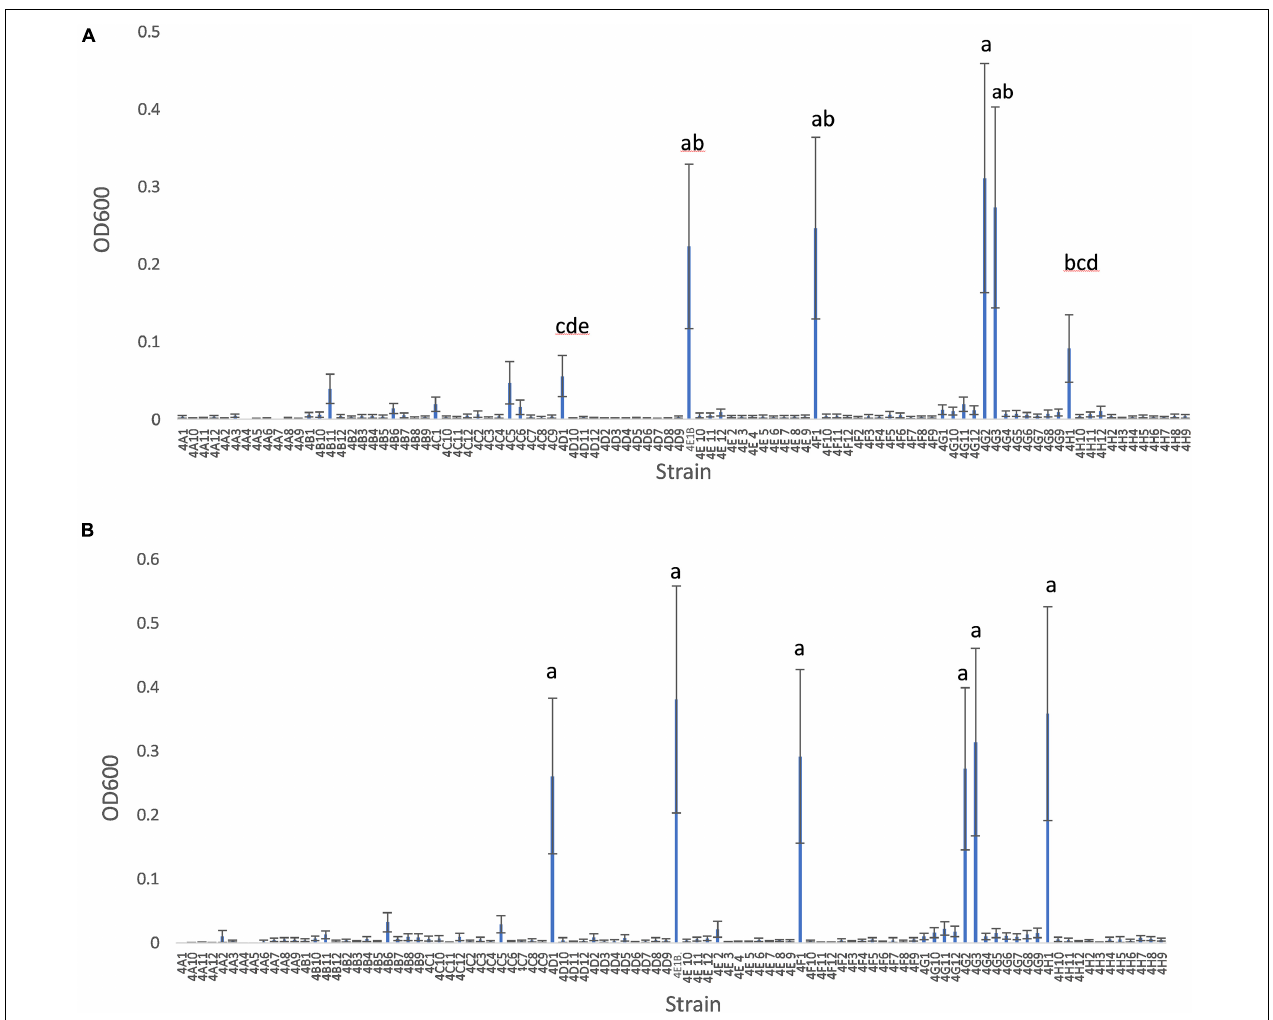
FIGURE 2 | In vitro growth of root and shoot maize endophytes in nitrogen free medium. (A) Trial 1. (B) Trial 2. Root and shoot endophytes stored in glycerol stocks in 96-well plates were inoculated into 900 µ l Burk’s N-free media in 96-deep well plates ( n = 3). These plates were incubated anaerobically at room temperature for 6 days. After 6 days, cultures were resuspended and OD 600 values were measured using a spectrophotometer. The error bars represent the standard error, and means with the same letter value are not statistically different.